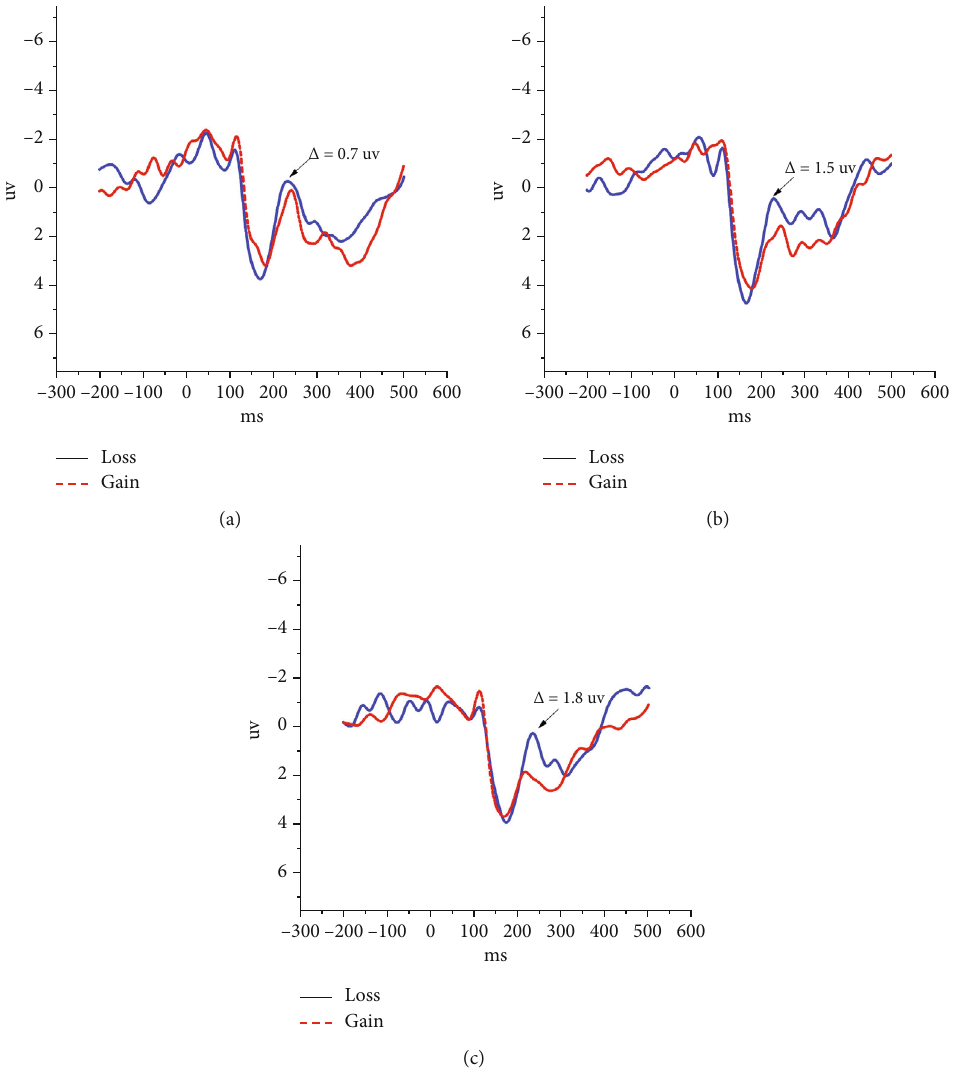
Figure 5: The EEG at Fz in every experiment after making the decision. The EEG showed negative-polarity ERP obviously in the 232 ms at Fz. There is an obvious absolute value of negative-polarity ERP produced by losses and gains. With the increase of E , the absolute value increased clearly. (a) In the fi rst experiment ( E = 5 ), the absolute value of waves produced by losses and gains is 0 : 7 μ v in the 232 ms. (b) In the second experiment ( E = 7 ), the value is 1 : 5 μ v . (c) In the third experiment ( E = 10 ), the value is 1 : 8 μ v . Table 2: The voltage amplitude of gains and losses after making the decision in di ff erent experiments.